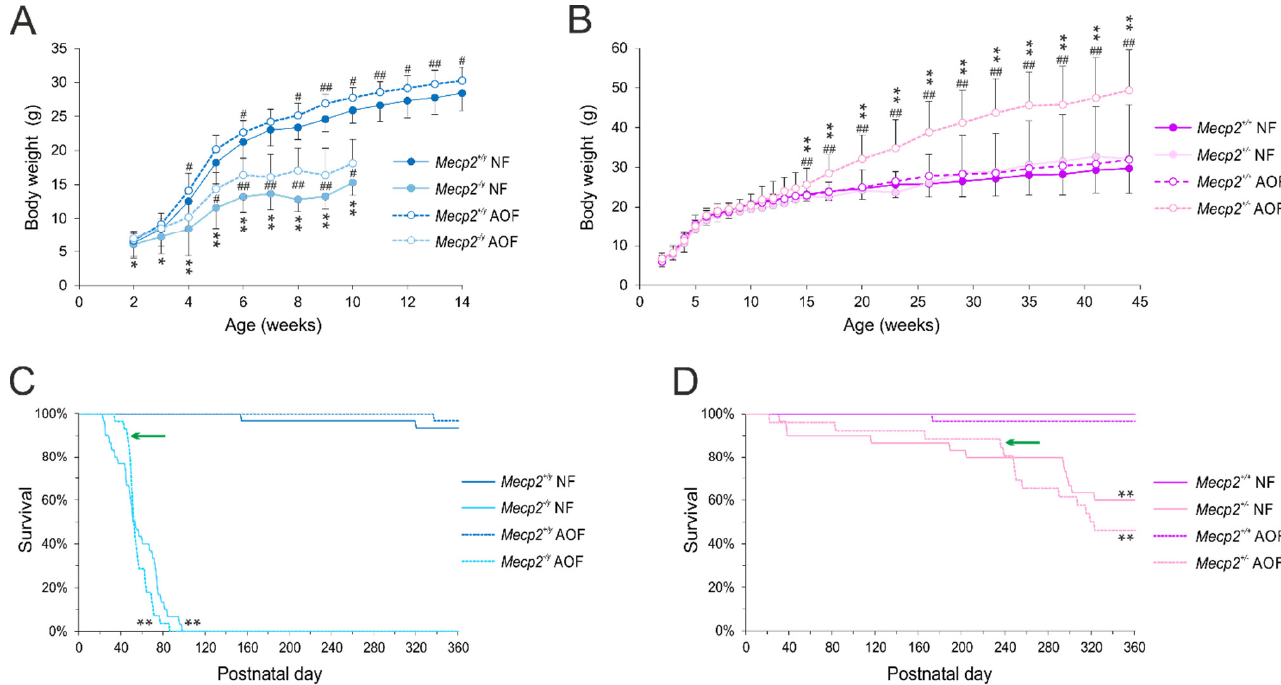
Figure 1. Antioxidant food (AOF)-mediated modulation of body weights and life expectancy. ( A , B ) In Mecp2 − / y mice, the AOs improved the weight gain but evoked an obese phenotype in Mecp2 +/ − mice. Plotted are the mean body weights ± standard deviations of 22–38 mice per group. Significant body-weight changes as compared with the respective WT group (two-way ANOVA, followed by Holm–Sidak post-hoc test) are indicated by asterisks (* p < 0.05, ** p < 0.01), and AO-treatment-mediated effects among either WT or Mecp2 -mutant mice are identified by crosshatches (# p < 0.05, ## p < 0.01). ( C , D ) In the Kaplan–Meier survival curves for male and female mice, the total life expectancy was not prolonged by AO treatment, but in Mecp2 − / y and Mecp2 +/ − mice, premature death during the first half of life tended to be less frequent (see green arrow marks). Plotted curves are based on 26–30 mice per group. Significant changes in the lifetime as compared with WT conditions with normal food (NF) were assessed using log-rank tests followed by Holm–Sidak pairwise comparisons (** p < 0.01).